Question: What type of chart is this?
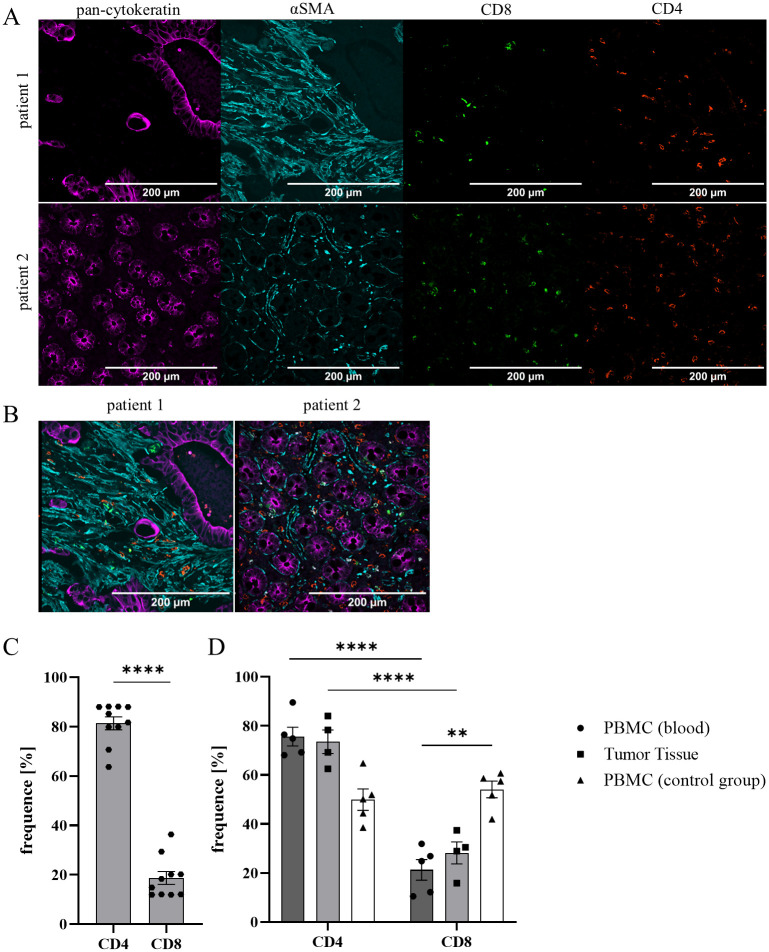
Answer: bar